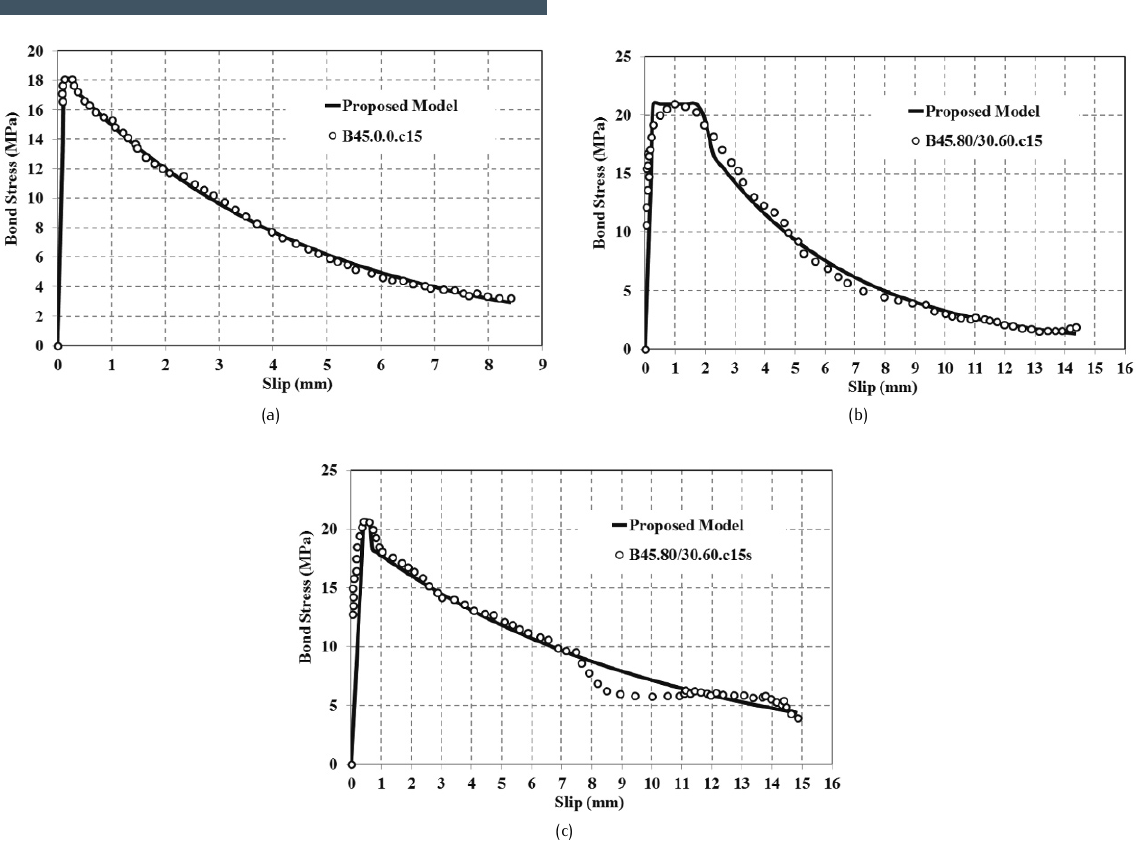
Figure 13. Comparison of the experimentally obtained load-slip curves (Schumacher [30]) versus the predicted curves by using the proposed model for (a) f 0 c = 45 , without fiber and concrete cover = 15, (b) f 0 c = 45 , with fiber aspect ratio: 80/30” and fiber content: 60 (kg/m 3 )”, and concrete cover = 15, and (c) f 0 c = 45 , with fiber “aspect ratio: 45/30” and “fiber content: 60 (kg/m 3 )”, and concrete cover = 15 sawn